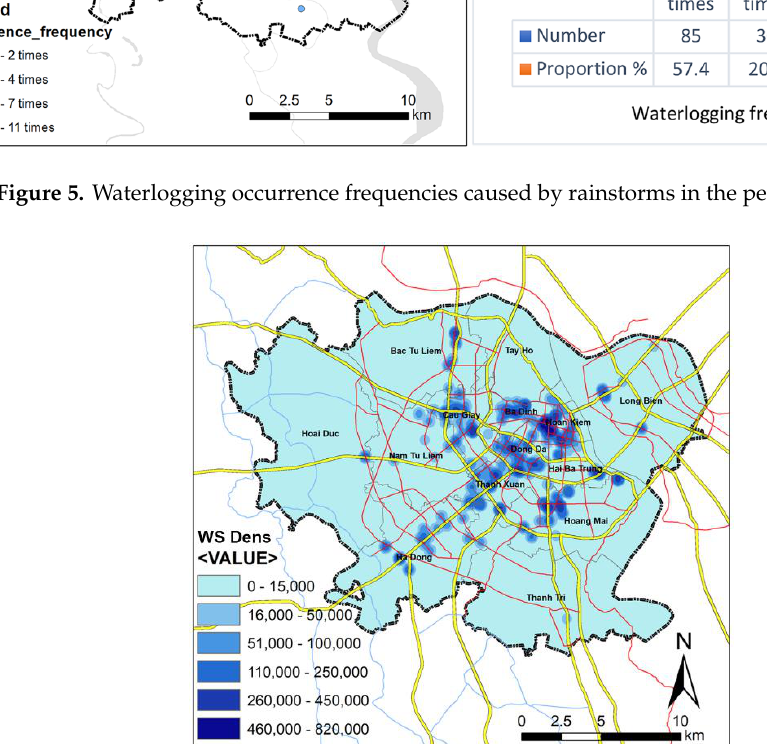
Figure 5. Waterlogging occurrence frequencies caused by rainstorms in the period 2012–2018.